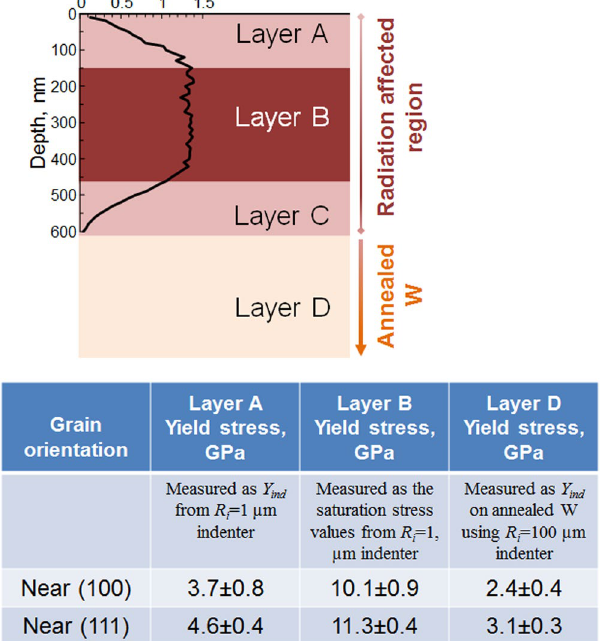
Figure 5. Schematic showing the He radiation affected region idealized into four layers labelled ( A ) through ( D ). The bottommost layer ( D ) denotes the virgin (undamaged and annealed) material below the radiation affected region. The table summarizes the results for the indentation measurements performed on the annealed and He irradiated tungsten